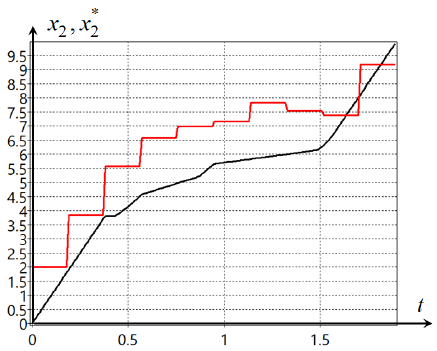
Figure A2. Plots of optimal x 2 and x 2 ∗ .